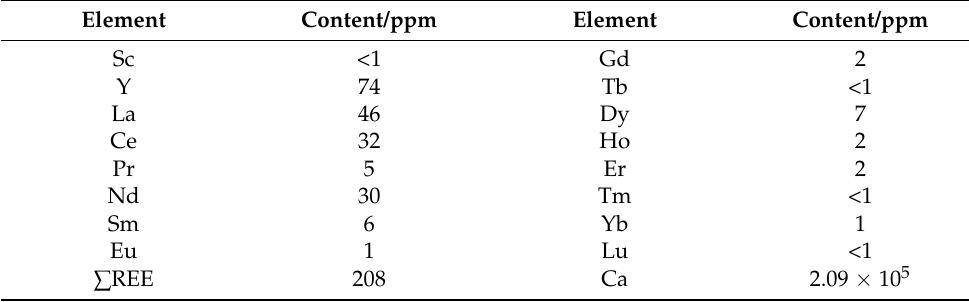
Table 2. Contents of REEs in the